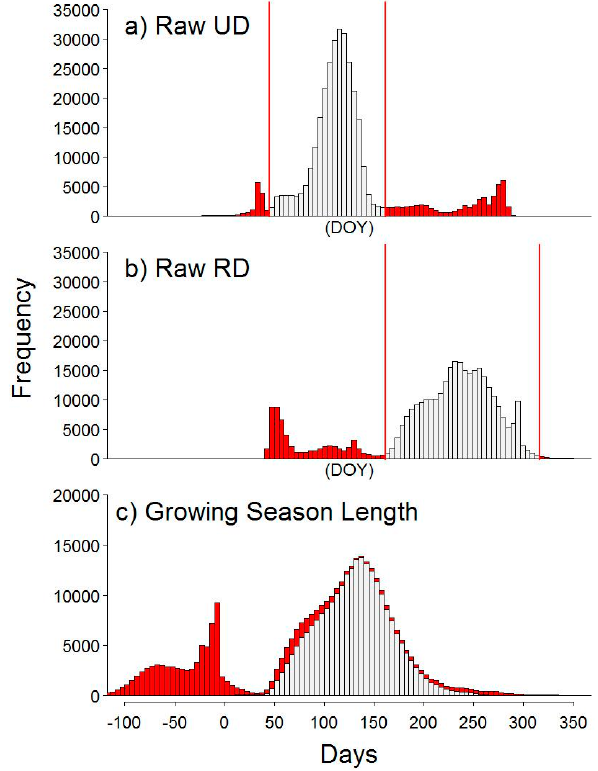
Figure 8. The manual filtering method used to determine pixels in the spatiotemporal analyses. Tick marks below bottom panel apply to all panels and are DOY for ( a , b ) and number of days for ( c ). ( a , b ) Vertical red lines represent lower and upper limits where pixels were removed due to bimodal distributions for upturn date (UD) and recession date (RD). Red bars are removed data. ( c ) Growing season length (GSL) calculated as the difference between RD and UD. Red bars illustrate pixels that characterized interspace and gray bars are pixels that characterized vegetation and were predominately sagebrush canopy. These data are used in the analyses in Figure 9.